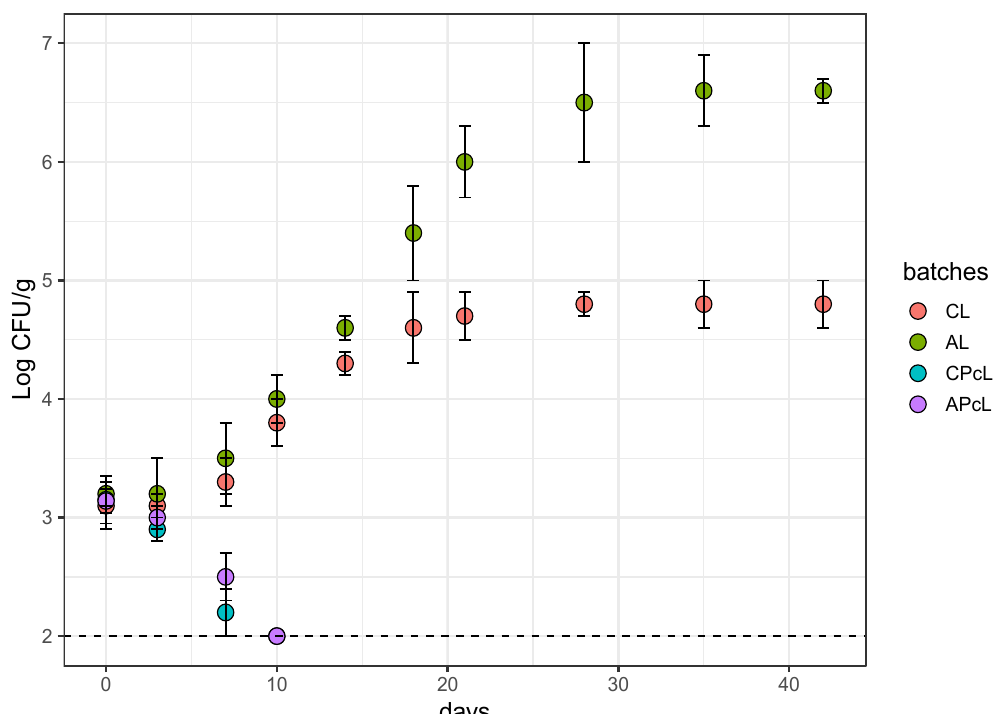
Figure 8. Scatterplot showing the challenge test of Listeria spp. during the ripening of fermented sausage from batch CL, fermented sausage prepared with starter culture and 14% minced pork 4 strains of L. innocua (3 Log CFU/g); batch AL, prepared with 4% lemon albedo in total replacement of pork fat and starter culture addition 4 strains of L. innocua (3 Log CFU/g); batch CPcL, prepared with starter culture and 14% minced pork addition plus anti- Listeria Lactiplantibacillus plantarum Lpls100 and 4 strains of L. innocua (3 Log CFU/g); batch APcL, prepared with 4% lemon albedo in total replacement of pork fat and starter culture addition plus anti- Listeria Lactiplantibacillus plantarum Lpls100 and 4 strains of L. innocua (3 Log CFU/g).